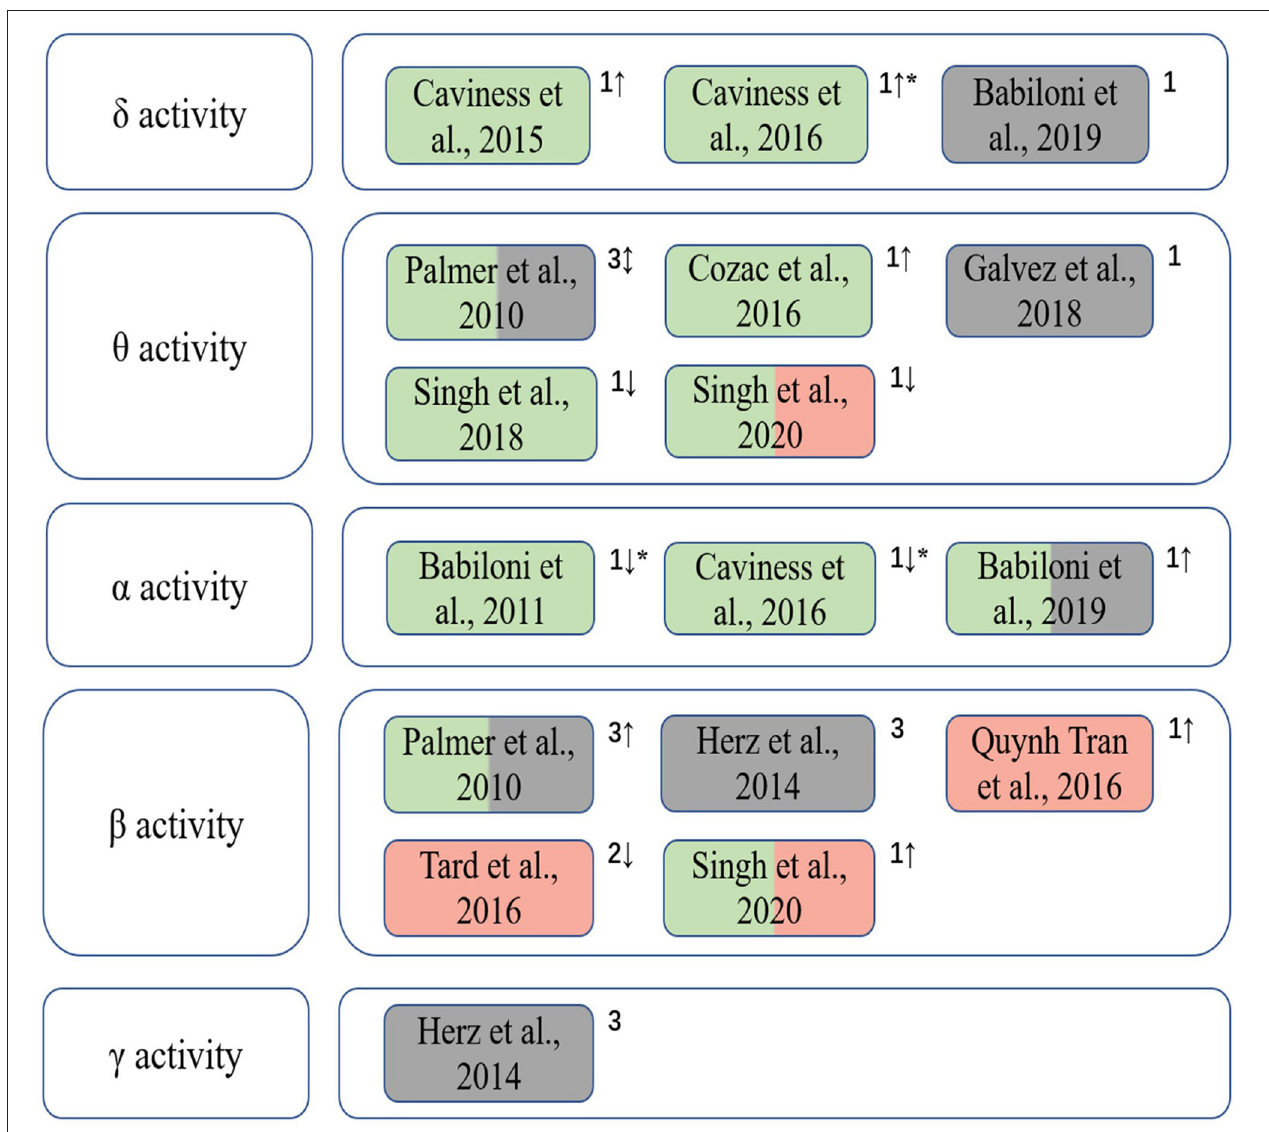
FIGURE 2 | The correlation between EEG spectral characteristics in different frequency bands and cognition and motor functions of PD patients. Green indicates that the EEG spectral characteristics is correlated with cognitive function; red indicates that it is correlated with motor performance; gray indicates that EEG spectral patterns are used to assess clinical treatment outcomes. 1, spectral power/power density; 2, event-related desynchronization/synchronization (ERD/ERS); 3, EEG connectivity; “ ↑ ,” the increase trend; “ ↓ ,” the decrease trend; “ l ,” different trends of EEG spectral characteristics in various brain regions when cognitive and/or motor symptoms appear; “*” indicates that the gradual changes of EEG features of patients from PD-CogNl to PD-MCI to PDD manifest decrements in cognitive